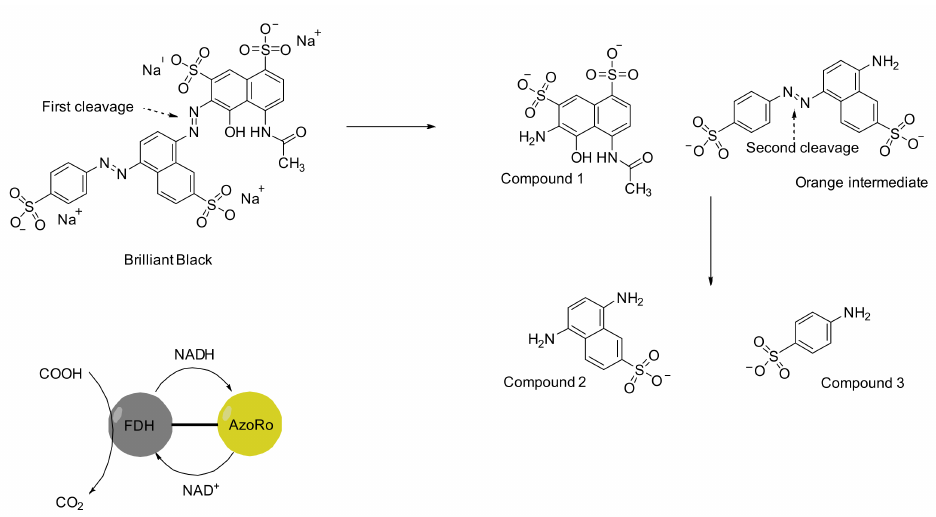
Figure 5. Reduction of Brilliant Black by a fusion protein comprised of the formate dehydrogenase (FDH) from Candida boidinii and the azoreductase (AzoRo) from Rhodococcus opacus 1CP according to an earlier reported observation of respective degradation compounds or intermediates